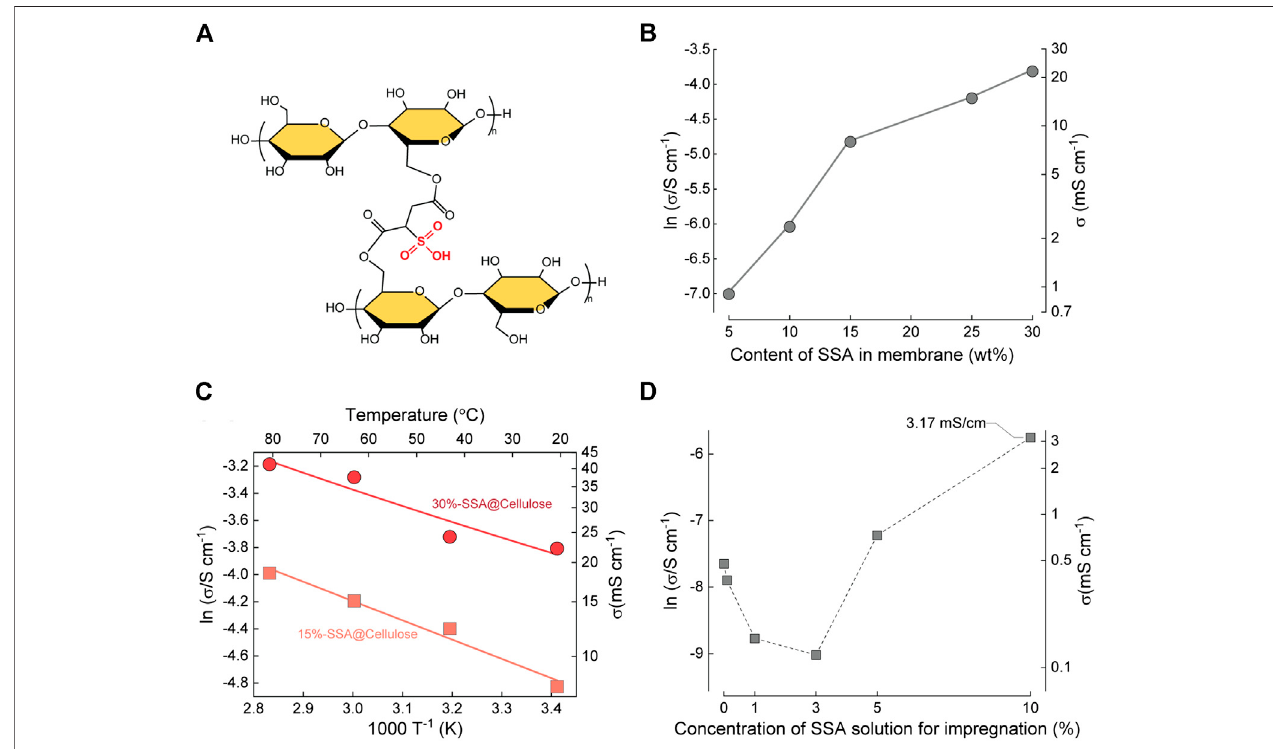
FIGURE 12 | (A) Chemical reaction for the preparation of sulfosuccinic acid (SSA) cross-linked cellulose membranes. (B) Proton conductivity of cellulose/SSA membranes as a function of crosslinker concentration. (C) Temperature-dependent proton conductivity of cellulose/SSA membranes with 30% and 15% of sulfosuccinic acid. Redrawn from Seo et al. (2009). (D) Proton conductivity of CNF/SA membranes as a function of SSA solution concentration used for impregnation Redrawn from Sriruangrungkamol and Chonkaew (2020).